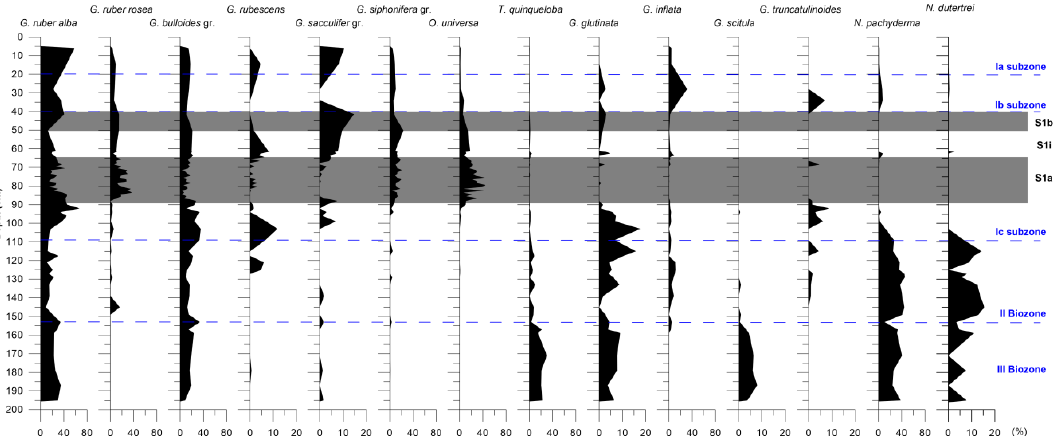
Figure 3. Frequency curves of the most indicative planktonic foraminiferal species in core KIM-2A. The dashed blue lines represent the Ia/Ib, Ib/Ic, Ic/II and II/III boundaries, whereas the gray bands the sapropel S1 sublayers respectively. X axes scales are of 80% and 20% corresponding to the high and low frequency abundances respectively.